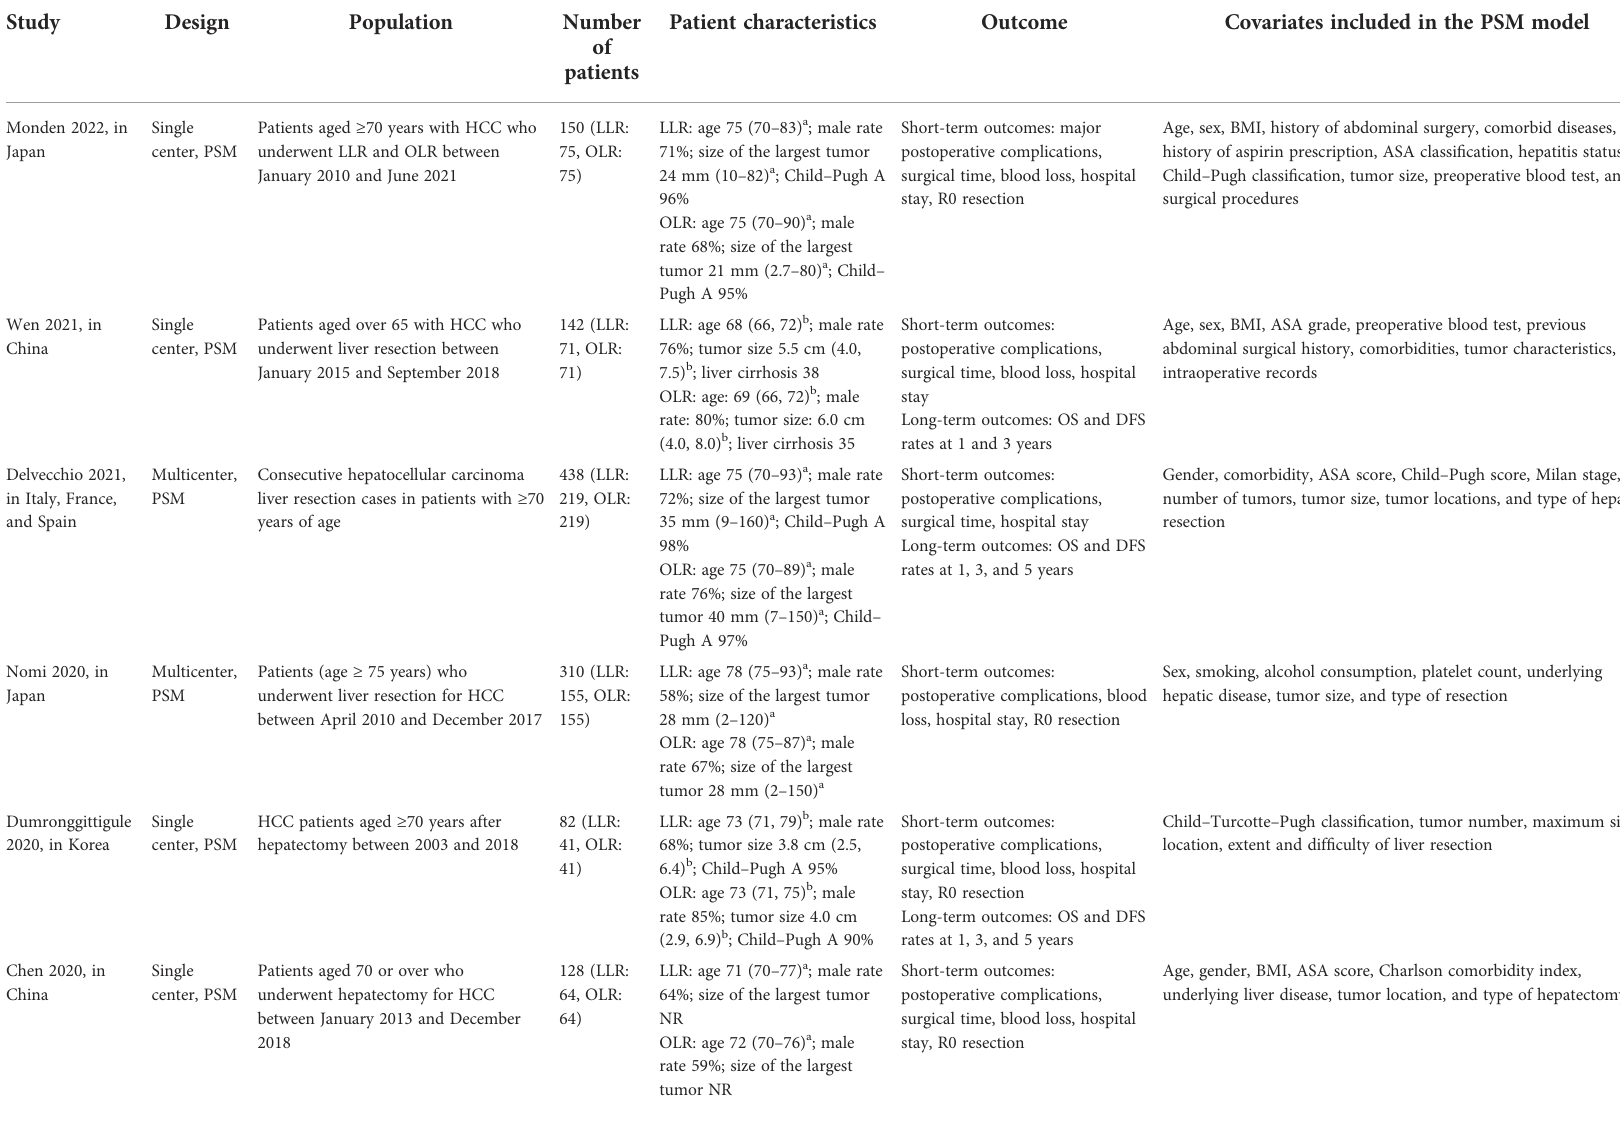
TABLE 1 Characteristics of the included